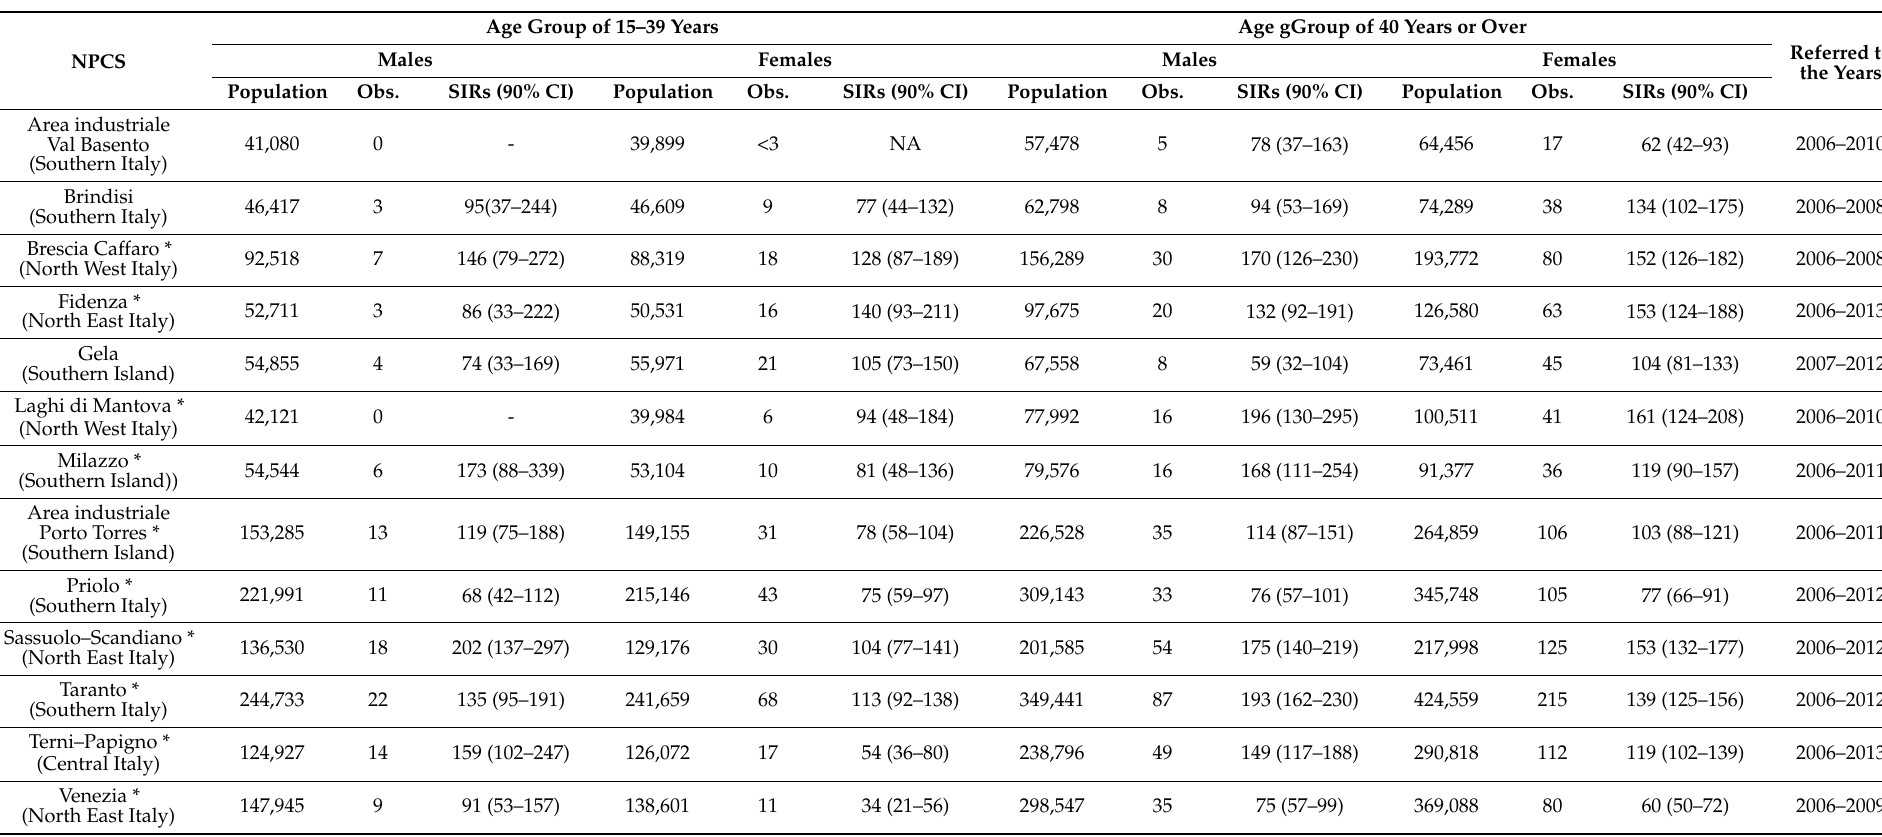
Table 2. Thyroid cancer Standardized Incidence Ratios (SIRs) with 90% confidence intervals (CIs) by gender, and age group in selected NPCSs with documented presence of EDs.